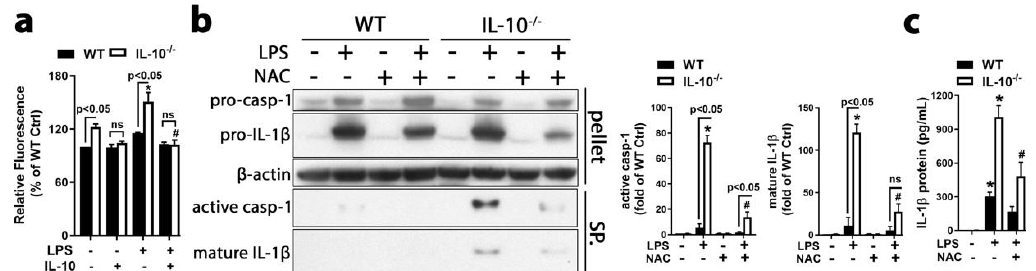
Figure 3. More accumulated ROS in IL-10 − / − microglia mediated NLRP3 inflammasome-dependent caspase-1 activation and IL-1 β secretion elicited by LPS. ( a ) Quantification of fluorescent intensity of fluorescent probe CM-H 2 -DCFDA showing more production of iROS in IL-10 − / − microglia-enriched cultures than WT microglia treated with LPS for 18 h. Pretreatment for 30 min with recombinant IL-10 blocked LPS-induced iROS production in IL-10 − / − microglia. ( b , c ) Pretreatment of microglia-enriched ( b ) and mix-glia cultures ( c ) with ROS scavenger NAC for 30 min blocked cleavage of pro-caspase-1 and pro-IL-1 β ( b ) and IL-1 β release ( b , c ) detected at 48 h after LPS treatment. Results are the mean ± SEM, and significance was determined by two-way ANOVA with Tukey’s multiple comparisons for a ( n = 2), b and c ( n = 3). * p < 0.05 as compared with the corresponding vehicle-treated control and # p < 0.05 as compared with the corresponding LPS-treated groups. CASP-1, caspase-1.